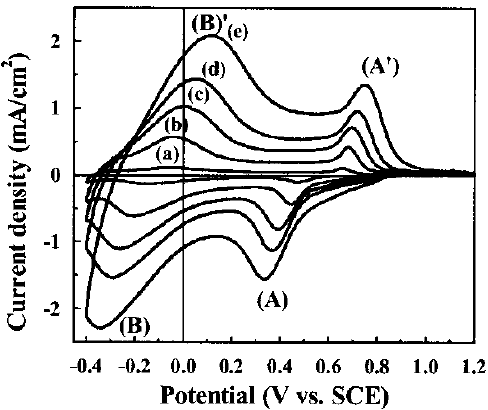
FIGURE 8 Cyclic voltammograms of 2400rpm spin-coated V 2 O 5 thin films at various sweeping rates: (a) 2mV = s, (b) 10mV = s, (c) 20mV = s, (d) 30mV = s and (e) 50mV =